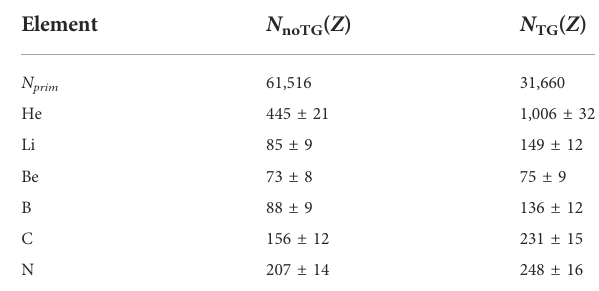
TABLE 3 Fragment yields extracted from GSI data for signal (fragmentation in TG + out of TG) and for background (fragmentation out of